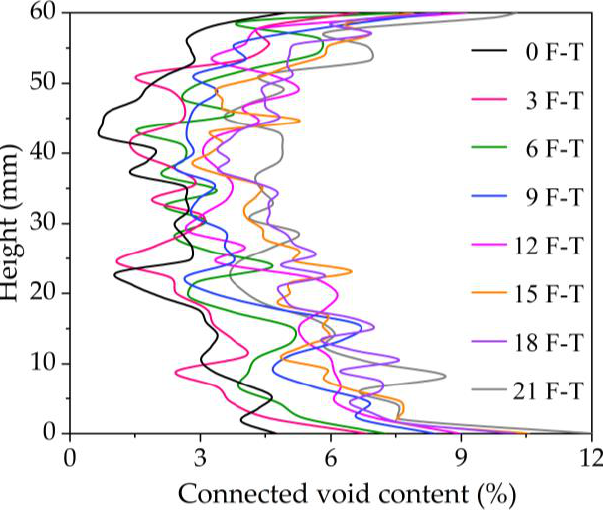
Figure 7. Distribution of internal connected void content of asphalt mixture under F – T cycles.